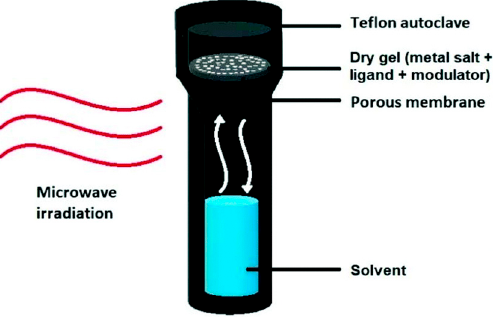
Figure 5. The schematic representation of MW–DSC. Reproduced with permission from [98].